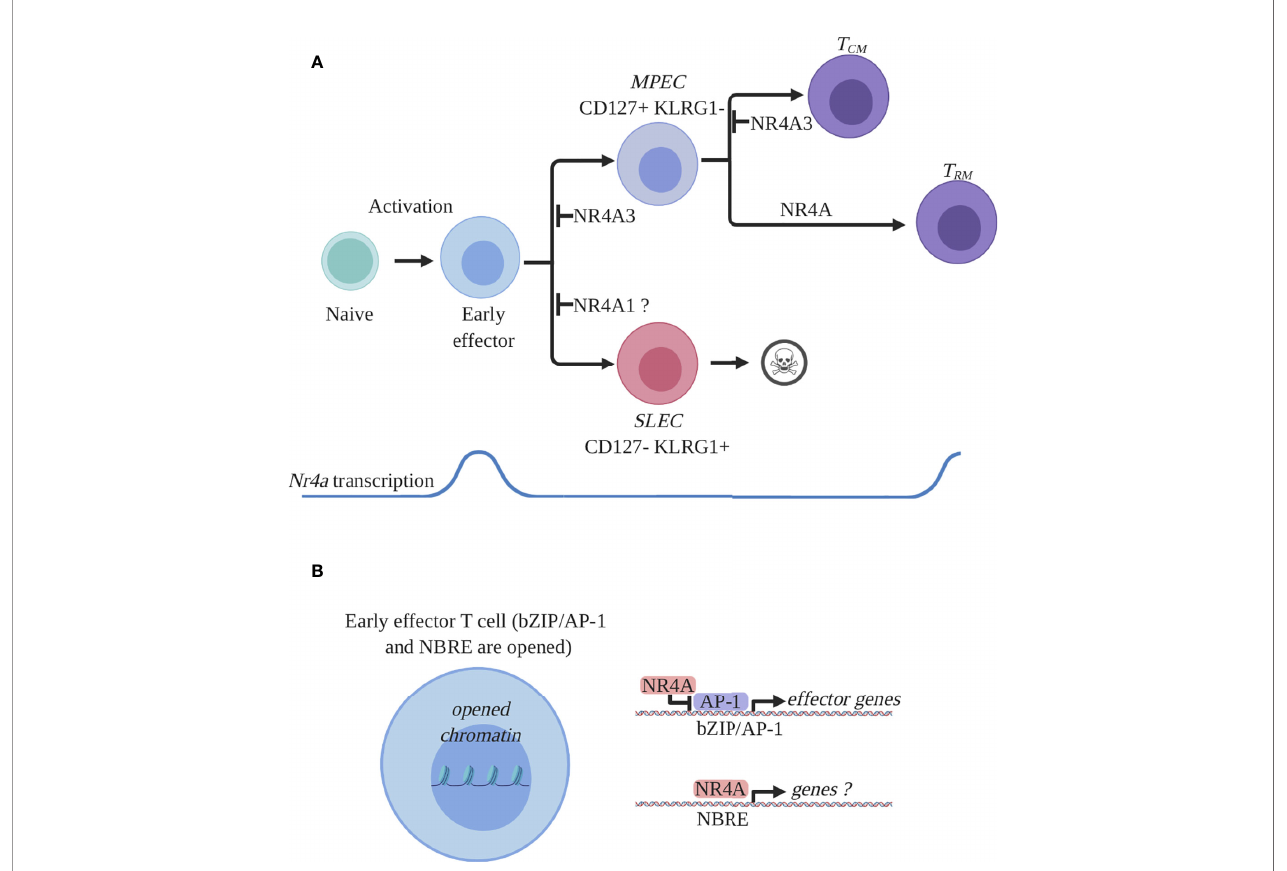
FIGURE 2 | NR4A family members expression and function in CD8 + T cells during an acute immune response. (A) Expression and role of NR4A members in CD8 + T cell response. Antigen recognition by naïve CD8 + T cells will induce a transcriptional program responsible for activation, proliferation, and differentiation and proliferation. Among the activation-induced genes are all the Nr4a transcription factors which are rapidly and transiently induced at the early effector stage. Early effector CD8 + T cells will further differentiate into effectors endowed with the ability to control the infection. Two main subpopulations of effectors are generated: short lived effector cells (SLEC) and memory precursor effector cells (MPEC). SLECs will die by apoptosis following pathogen clearance while MPECs will survive and differentiate into memory T cells. At the effector stage, NR4A1 was shown to either inhibit or have no effect on SLEC differentiation while NR4A3 was shown to diminish MPEC differentiation. At the memory stage, the Nr4a transcription was shown to be enriched in a particular subset of memory CD8 + T cells, the resident memory CD8 + T cells (Trm). All the NR4A family members participate in the differentiation of CD8 + Trm cells while only NR4A3 was shown to in fl uence central memory CD8 T cell (Tcm) differentiation. (B) Proposed molecular mechanism by which NR4A in fl uences effector CD8 + T cell differentiation. CD8 + T cell activation will lead to the opening of the chromatin allowing for the transcriptional activity of different transcription factors involved in CD8 + T cell response. Among these transcription factors are bZIPs and NR4As which bind bZIP or NBRE DNA-binding motifs. Thus, bZIP TFs will occupy their recognition motifs on DNA and will drive the transcription of the effector- and differentiation-related genes. NR4A will in fl uence CD8 + T cell transcriptional response by competing with bZIPs for DNA occupancy and by directly regulating genes containing NBRE motifs. The identity of the genes directly regulated by NR4A are still unknown. This fi gure was created with